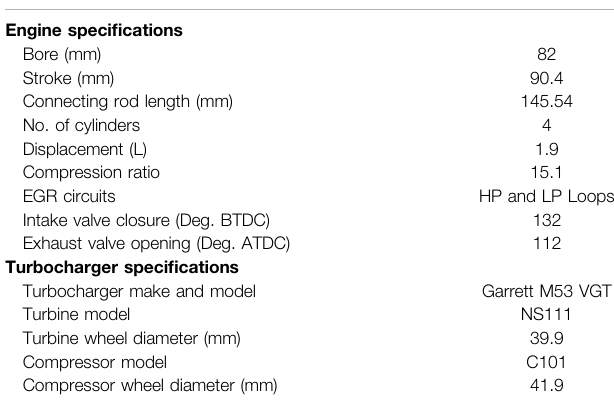
TABLE 2 | Operating parameters for cruise condition — 8 Bar BMEP at 3,000 rev min − 1